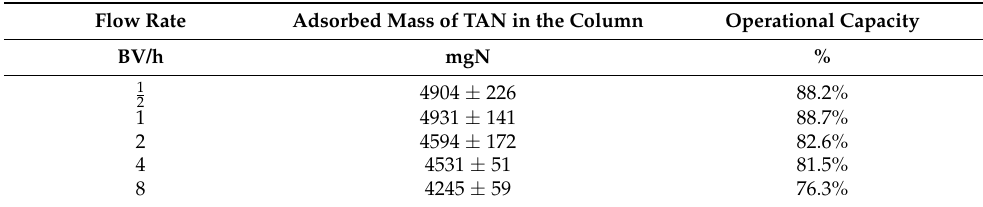
Table 4. Adsorbed mass and calculated operational capacity at the tested flow rates (22 BV, [TAN] 0 = 600 mgN/L).